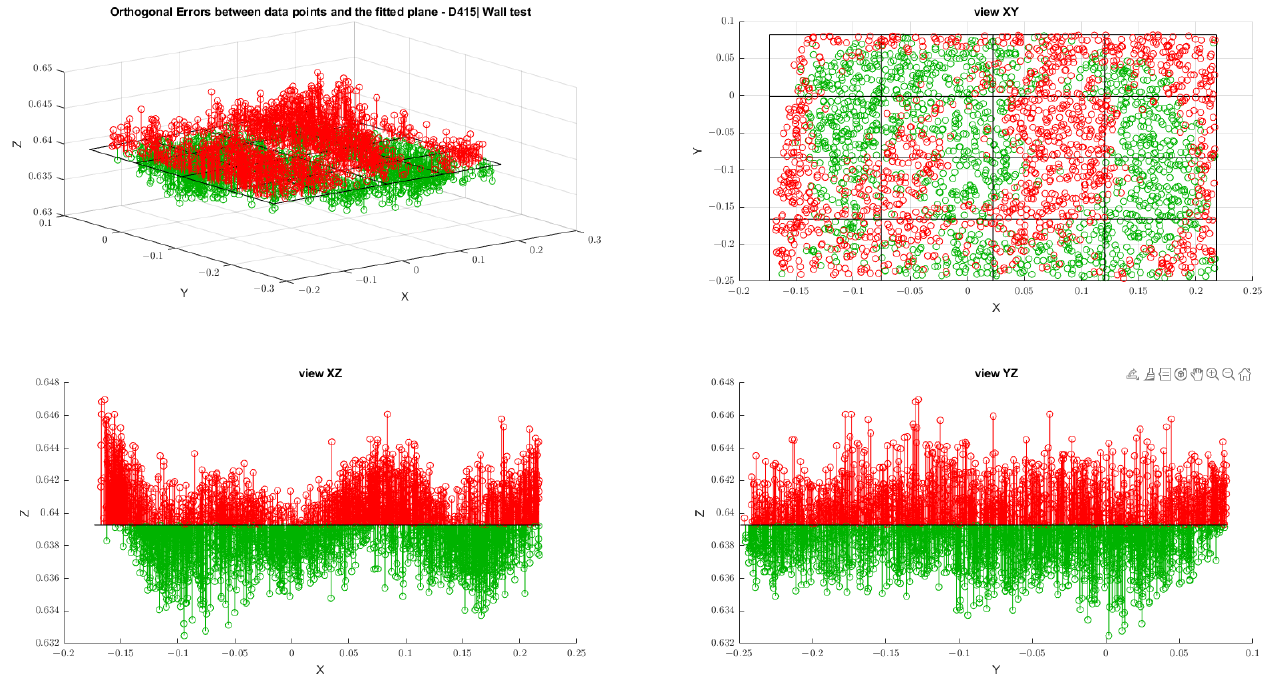
Figure A1. Results of orthogonal errors for the D415 camera referring to the wall test.